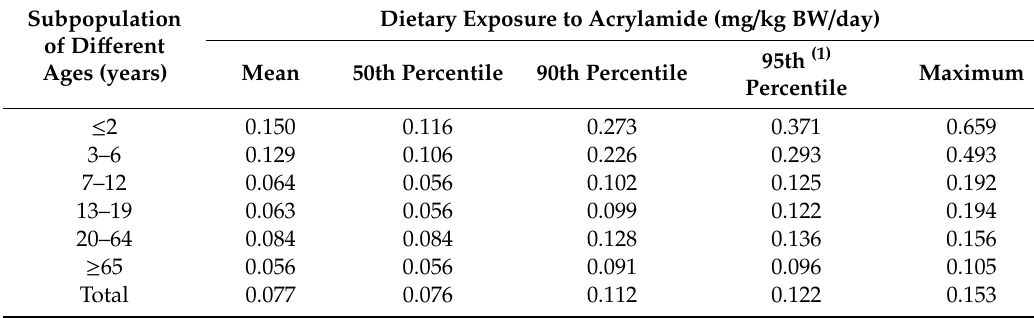
Table 2. Estimated dietary exposure to acrylamide among subpopulations of di ff erent ages.